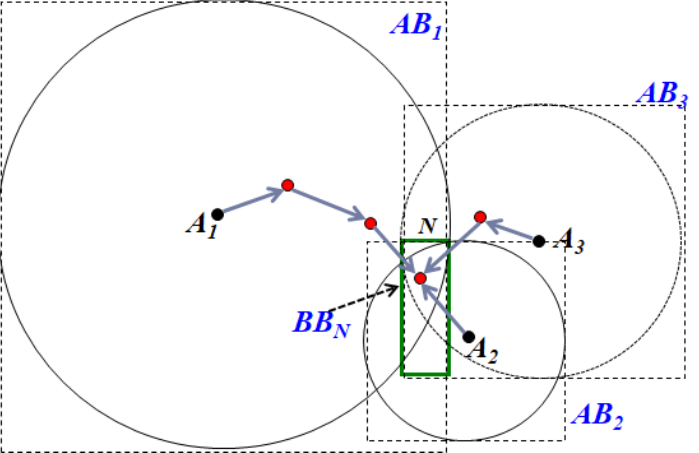
Figure 2. Bounding box localization method.